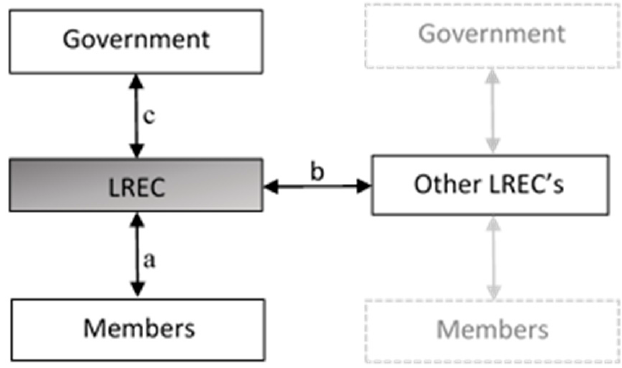
Figure 1. Key governance relations (a, b, c) that are the focus of the proposed research (authors’ own) .